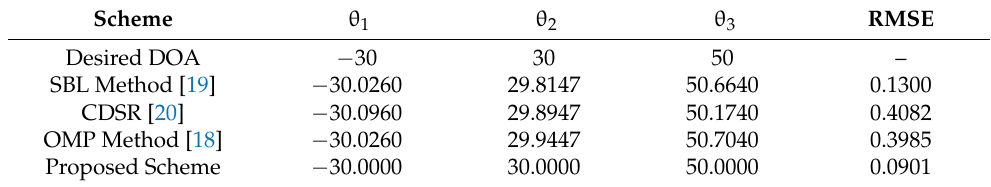
Table 6. DOA Estimation for Three Targets for N = 5 and M = 10 with SNR = 20 dB. Scheme